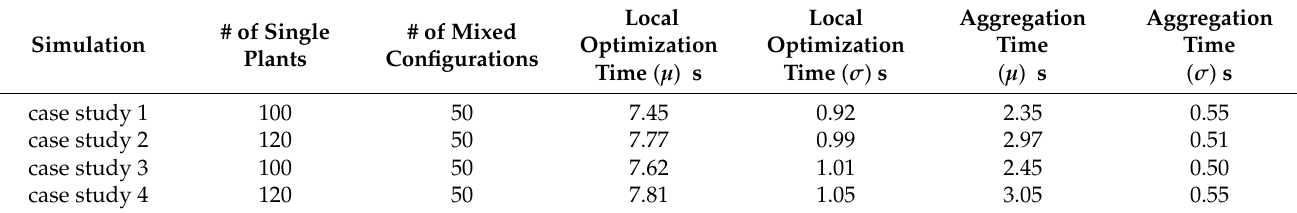
Table 4. Comparison number of plants/time for the 4 case study